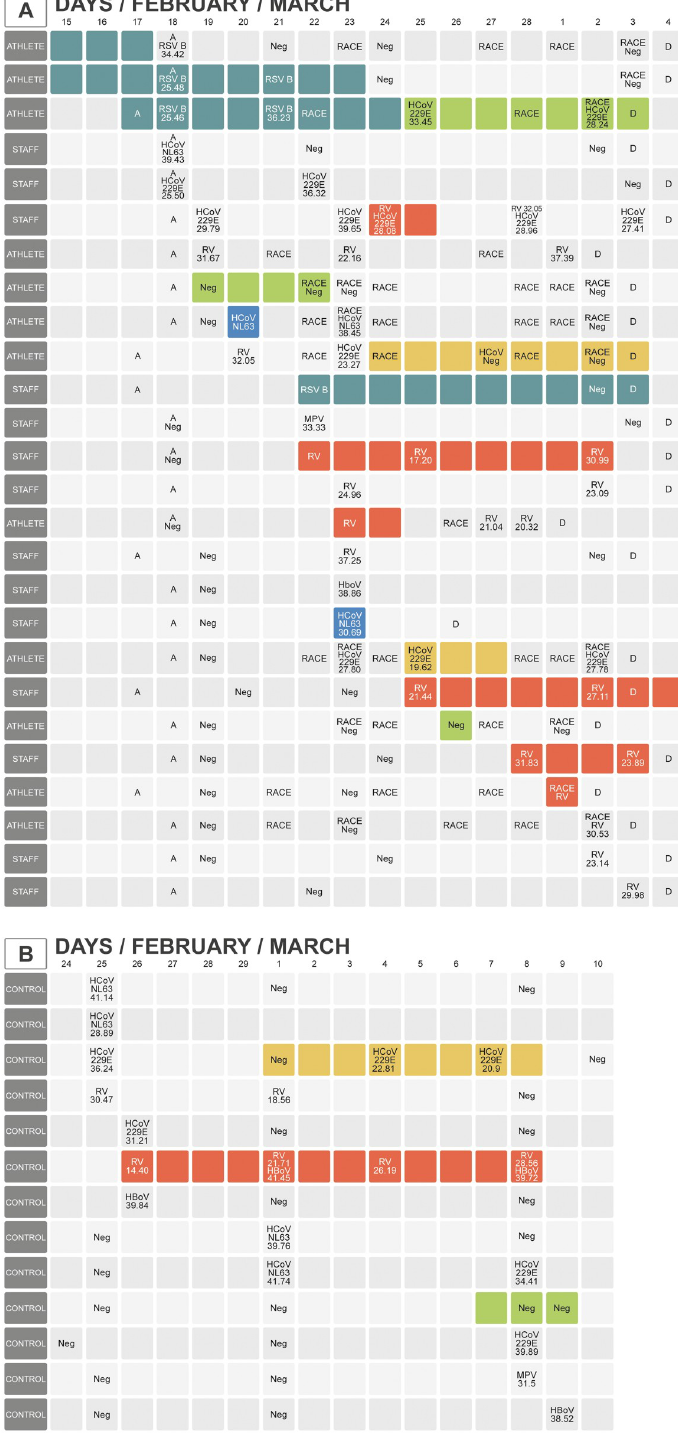
Fig 2. Occurrence and etiology of viral infections. The Fig 2A shows the transmission chain of symptomatic and asymptomatic infections in Team Finland. A = day of arrival at the hotel; D = departure from the hotel. The colored bars represent different viruses and the length of the bar indicates the duration of respiratory symptoms in days. RSV B, respiratory syncytial virus B; HCoV 229E, human coronavirus 229E; HCoV NL63, human coronavirus NL63; MPV, human metapneumovirus; RV, rhinovirus; HBoV, human bocavirus. The numbers in the boxes give Ct-values which